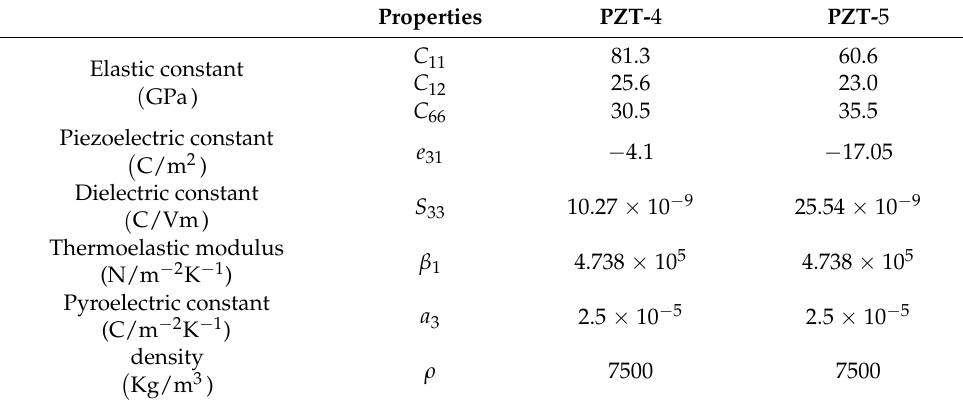
Table 2. Physical parameter values at room temperature.